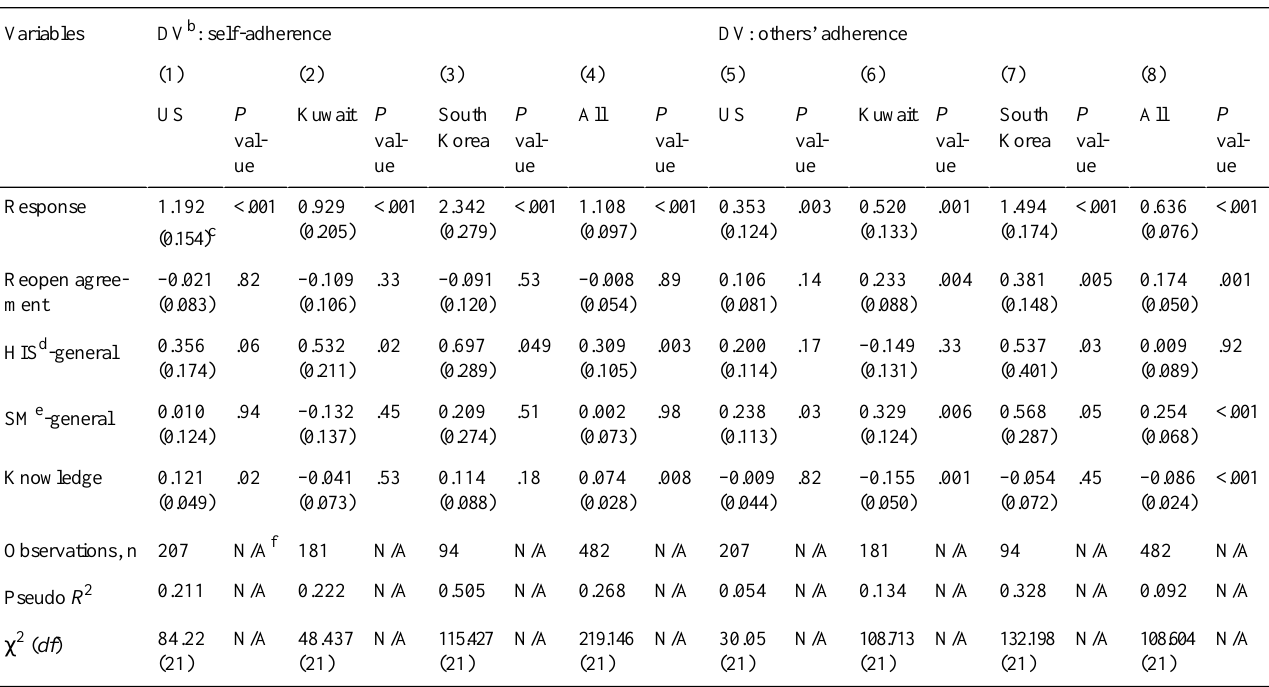
Table 2. Ordered probit regression. a